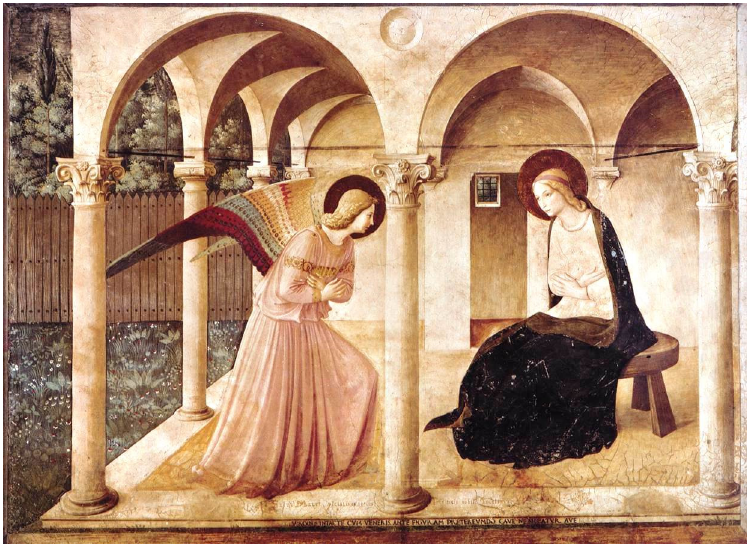
Figure 2. Fra Angelico, The Annunciation , c. 1440–1450. Convento di San Marco,